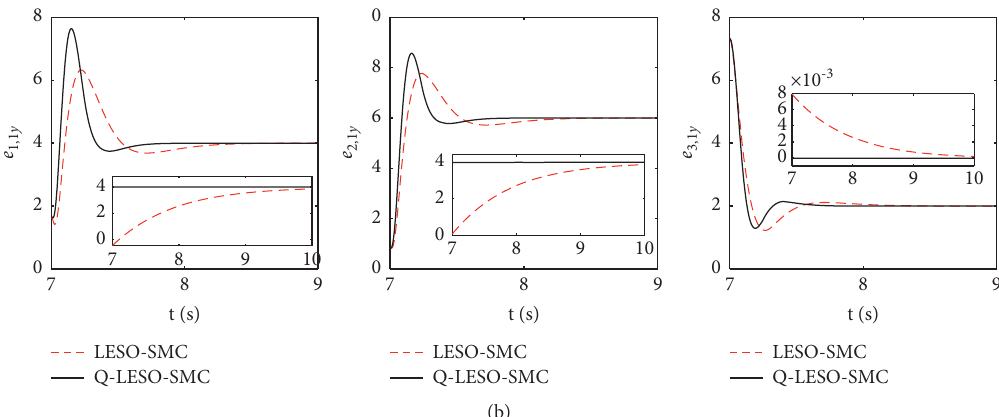
Figure 7: The formation tracking position error e i, 1 in Case A. (a) The formation tracking position error of the x -direction of the i th agent i � 1, 2, 3. (b) The formation tracking position error of the y -direction of the i th agent i � 1, 2, 3.